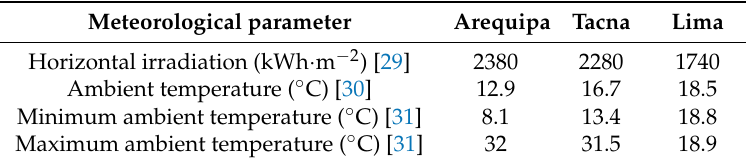
Table 1. Annual average values of some relevant meteorological parameters recorded in Arequipa, Lima, and